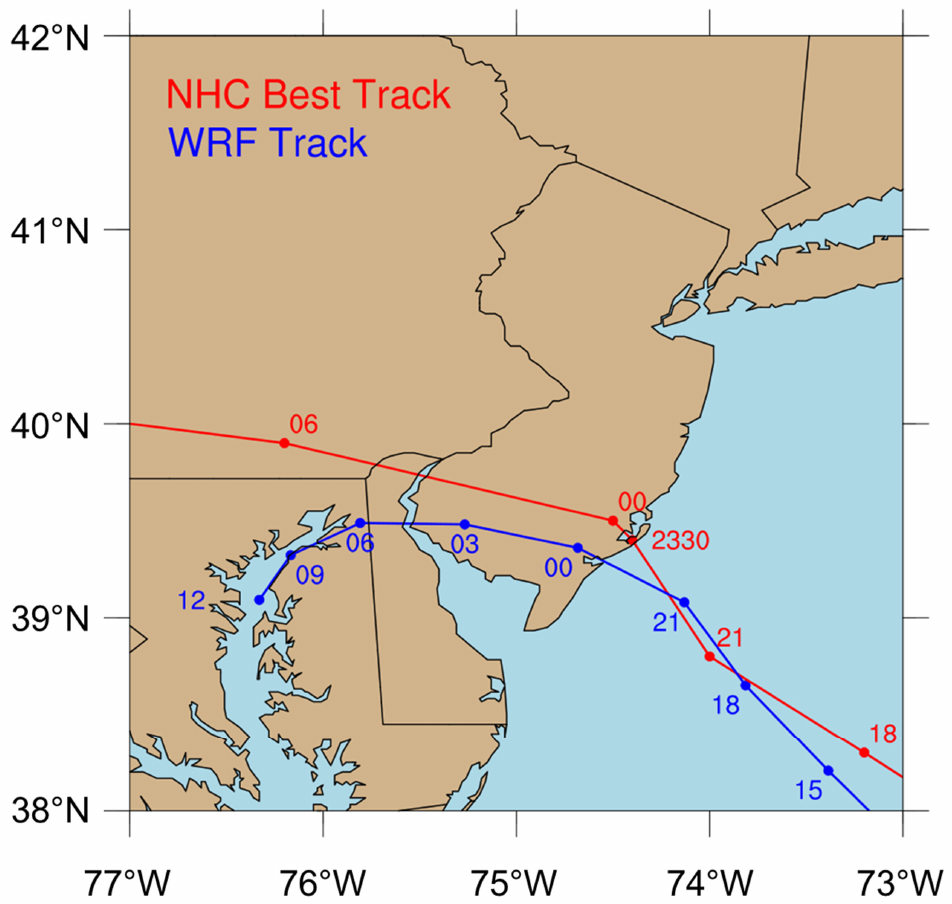
Figure 4. Comparison of actual and simulated storm center tracks. Red lines denote actual track based on National Hurricane Centre (NHC) best track data [22], and blue lines denote Weather Research and Forecasting (WRF)-simulated track indicated by the position of the minimum sea level pressure.